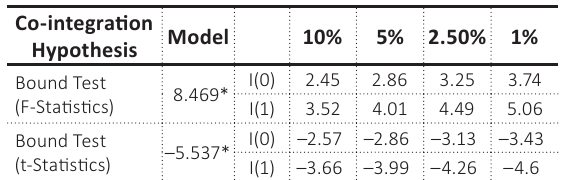
Table 2. Unit root results